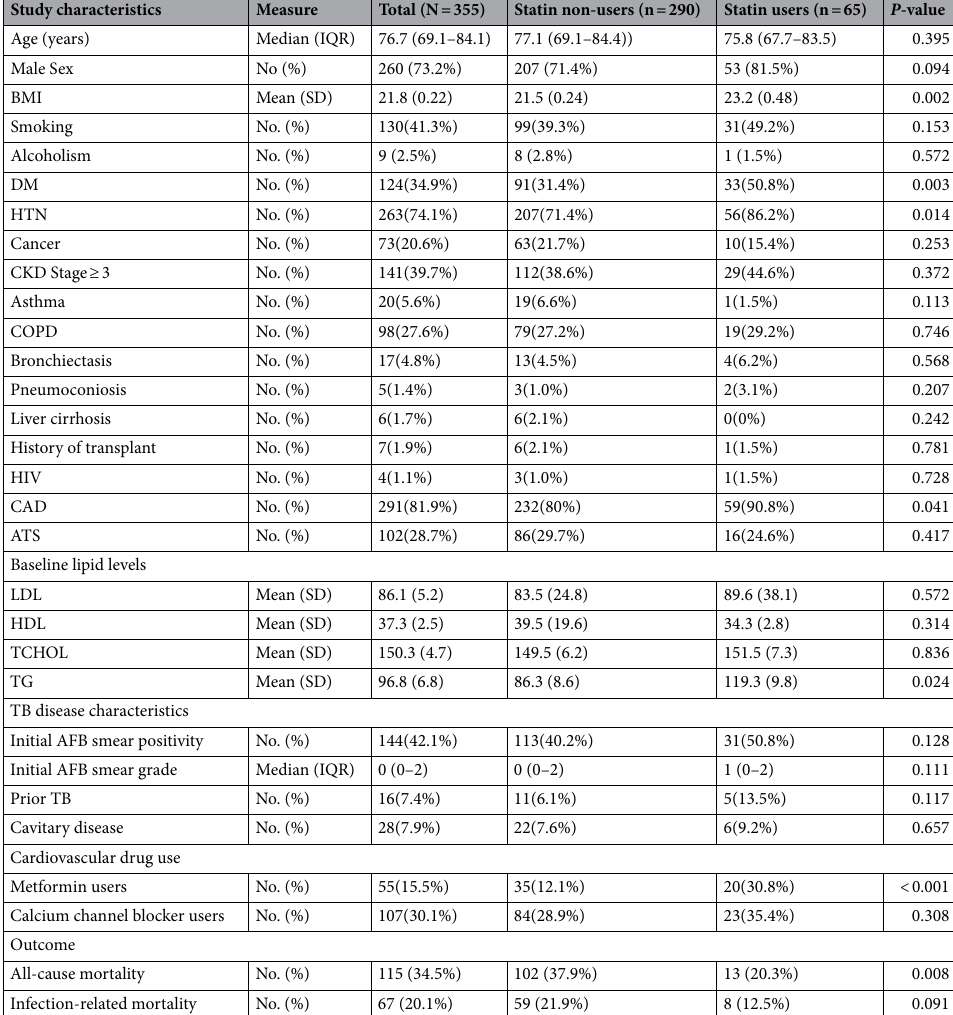
Table 5. Patient characteristics stratified by statin user in patients with cardiovascular disorders. AFB: Acid-fast bacilli; BMI: Body mass index; ATS: Atherothrombotic stroke, CAD: Coronary artery disease; CAD + AMI + : Coronary artery disease with history of Acute myocardial infarction; CAD + AMI-: Coronary artery disease without history of Acute myocardial infarction; CCB: Calcium channel blocker; CCI: Charlson comorbidity index; CHF: Congestive heart failure; CKD: Chronic kidney disease; COPD: Chronic obstructive pulmonary disease; CVA: Cerebrovascular accident; DM: Diabetes mellitus; HDL: High density lipoprotein cholesterol; HIV: Human immunodeficiency virus; HTN: Hypertension; IQR, Interquartile range; LDL: Low density lipoprotein cholesterol; PVD: Peripheral vascular disease; SD: Standard